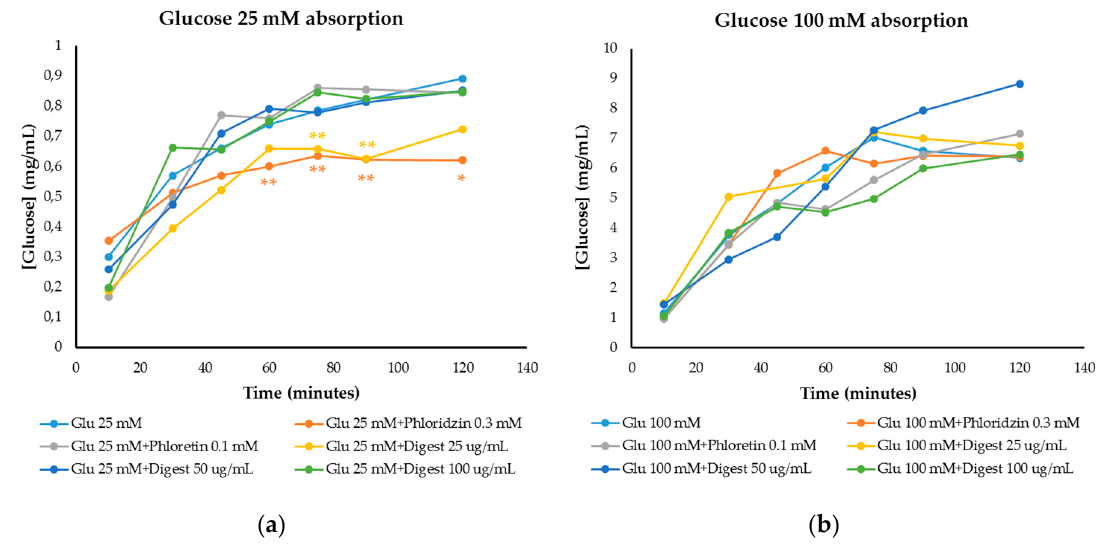
Figure 2. Glucose absorption in IEC-6 cells over time against reference inhibitors of glucose transporters (phloridzin and phloretin) and against the digestive simulation of the extract (digest) in the presence of ( a ) 25 mM glucose and ( b ) 100 mM glucose. Graphs of [Glucose] (mg/mL) vs. time (minutes). ANOVA analysis was performed by separated times using LSD Fisher test to state significant differences. *: p < 0.1 ; **: p < 0.05.